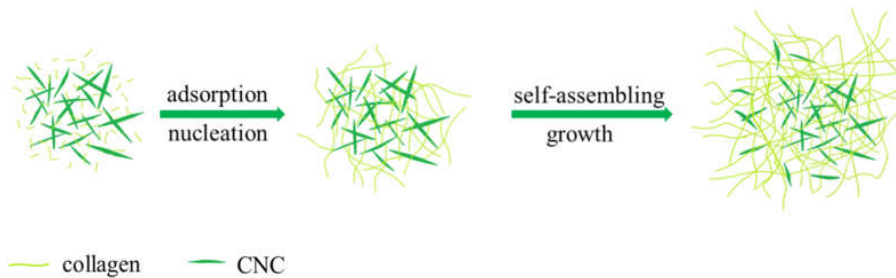
Scheme 1. Schemetic illustration of the collagen self-assembly in the presence of